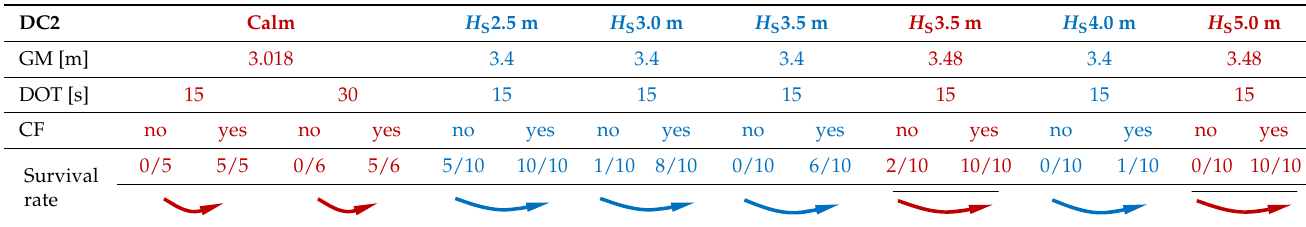
Table 5. Numerical (blue) and experimental (red) flooding mitigation results with counter flooding in Damage Case 2, T p = 10.0 s.